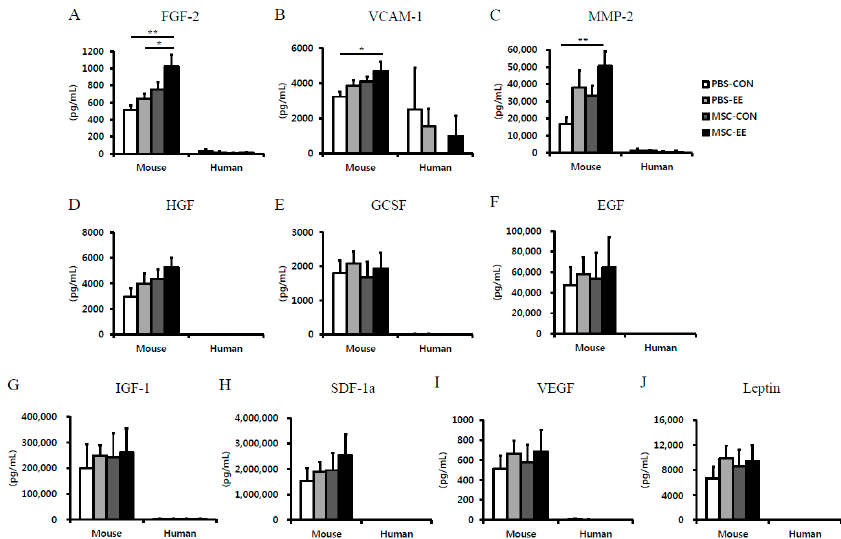
Figure 4. The angiogenic factors increased in the striatum of MSC-EE mice. ( A – J ) Two weeks after MSC transplantation and exposure to EE, the striatum were lysed and the levels of angiogenic proteins including FGF-2, VCAM-1, MMP-2, HGF, GCSF, EGF, IGF-1, SCF-1a, and Leptin were determined by a mouse-specific ELISA array; ( A – C ) The levels of FGF-2, VCAM-1 and MMP-2 were significantly higher in the right neostriatum of MSC-EE mice than it was in the PBS-CON tissues two weeks after treatment (* p < 0.05 and ** p < 0.01, n = 5, 4, 4, and 4 for PBS-CON, PBS-EE, MSC-CON, and MSC-EE, respectively). In a human-specific ELISA array, most of proteins were not detected. Values represent mean + SEM.